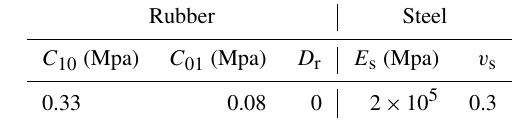
Table 1. Material coefficients.